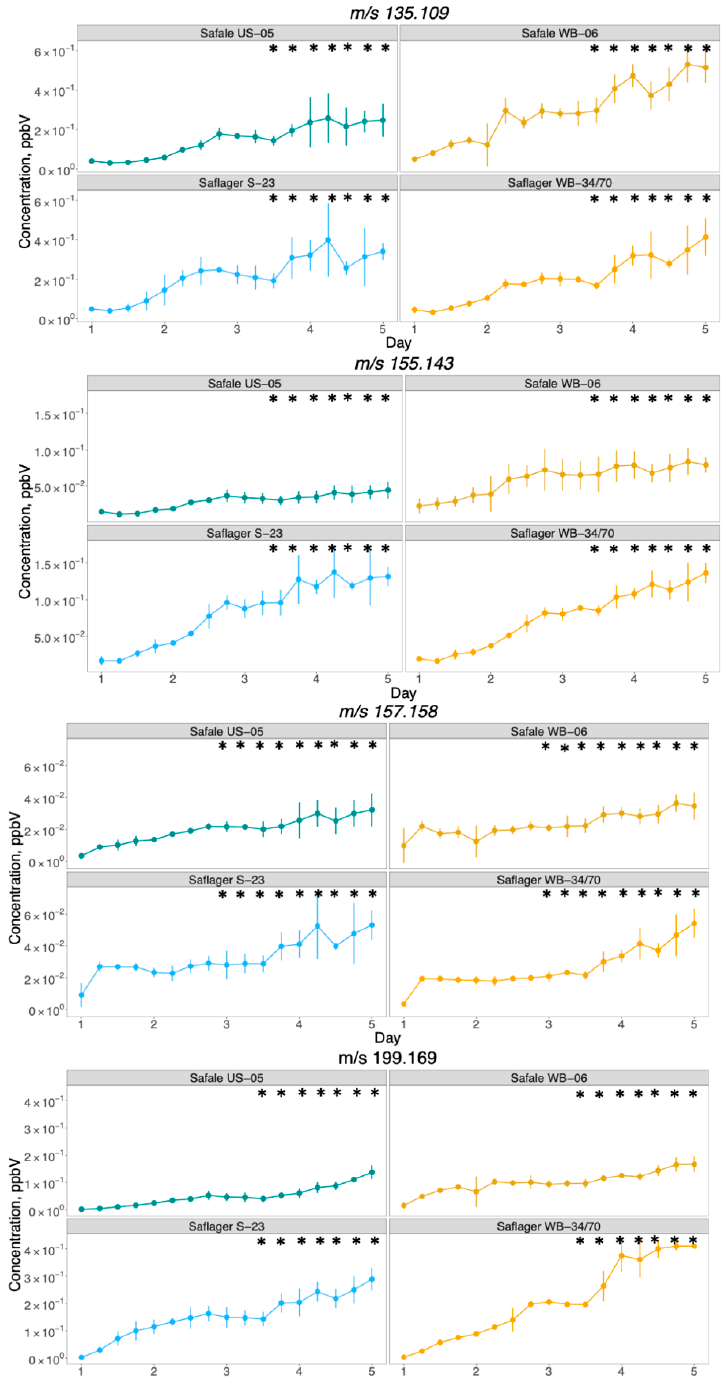
Figure 6. Mean concentration (ppbV) of geranyl acetate ( m / z 135.109 ), geraniol ( m / z 155.143), citronellol ( m / z 157.158 ) and citronellyl acetate ( m / z 199.169 ) during fermentation by commercially available yeast: Saccharomyces cerevisiae strain SafAle US-05, Saccharomyces cerevisiae var Diastaticus strain SafAle WB-06 and Saccharomyces pastorianus strains SafLager S-23 and SafLager W-34/70. Data presented as mean ± standard deviation of seven independent measurements. Asterisk (*)